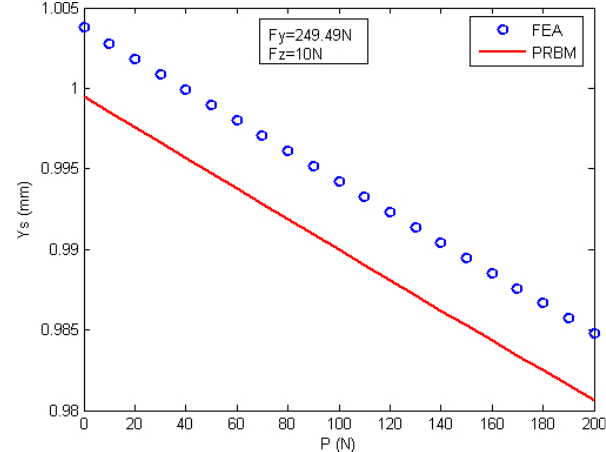
Figure 8. Primary translational displacement verification: cross- axis coupling e ff ect caused by the axial force.